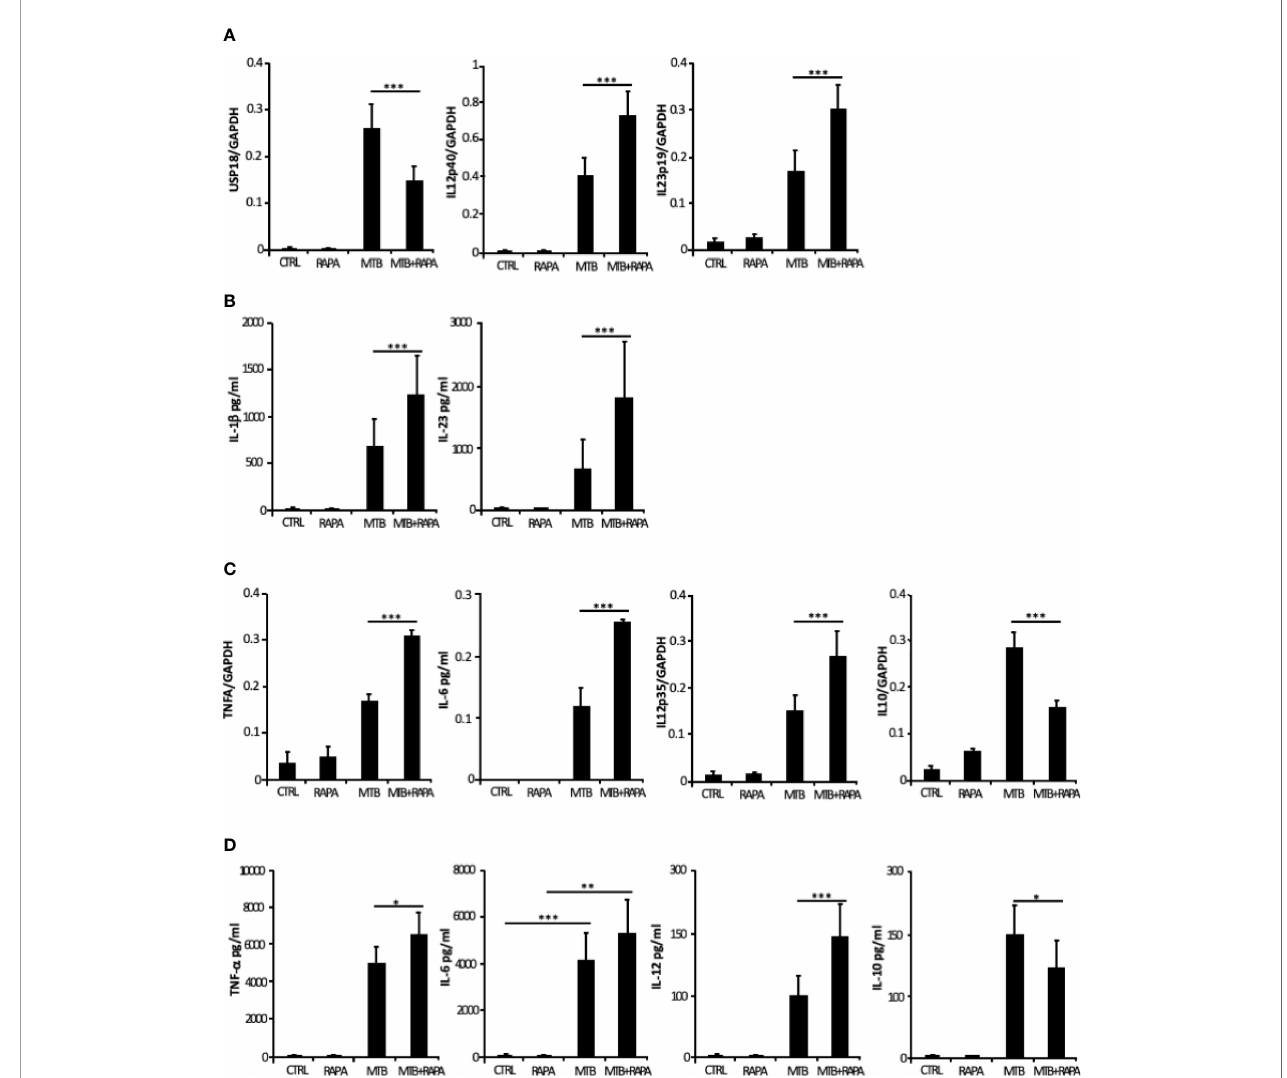
FIGURE 5 | Validation of transcriptome data on cytokine expression and production. Total RNA was extracted from untreated DC (CTRL), DC stimulated for 12 h with rapamycin (RAPA) or infected for 16 h with Mtb alone (MTB) or in combination with rapamycin added 4 h post infection (MTB+RAPA). For protein determination in culture supernatants, DC were left untreated (CTRL) or stimulated for 20 h with rapamycin (RAPA) or infected for 24 h with Mtb alone (MTB) or in combination with rapamycin added 4 h post infection (MTB+RAPA). (A) USP18, IL12p40 , and IL23p19 levels were evaluated by quantitative real time PCR. Data are represented as the mean copy number per sample ± standard error of 4 experiments performed with RNAs derived from a set of experiments independent than those used in transcriptome/translatome studies and that yielded similar results. (B) IL-1 b production was evaluated by In fl ammatory Cytokine bead array kit, while IL-23 release was measured by ELISA. The results represent mean values ± standard error of 8 independent experiments. (C) TNFA , IL6 , IL12p35 , and IL10 levels were analyzed as described in (A) . (D) The secretion of TNF- a , IL-6, IL-12, and IL-10 was quanti fi ed by using In fl ammatory Cytokine bead array kit. The results represent mean values ± standard error of 8 independent experiments. Signi fi cance was calculated by analysis of variance (ANOVA) followed by multiple comparison performed with Tukey ’ s test as speci fi ed in Materials and Methods